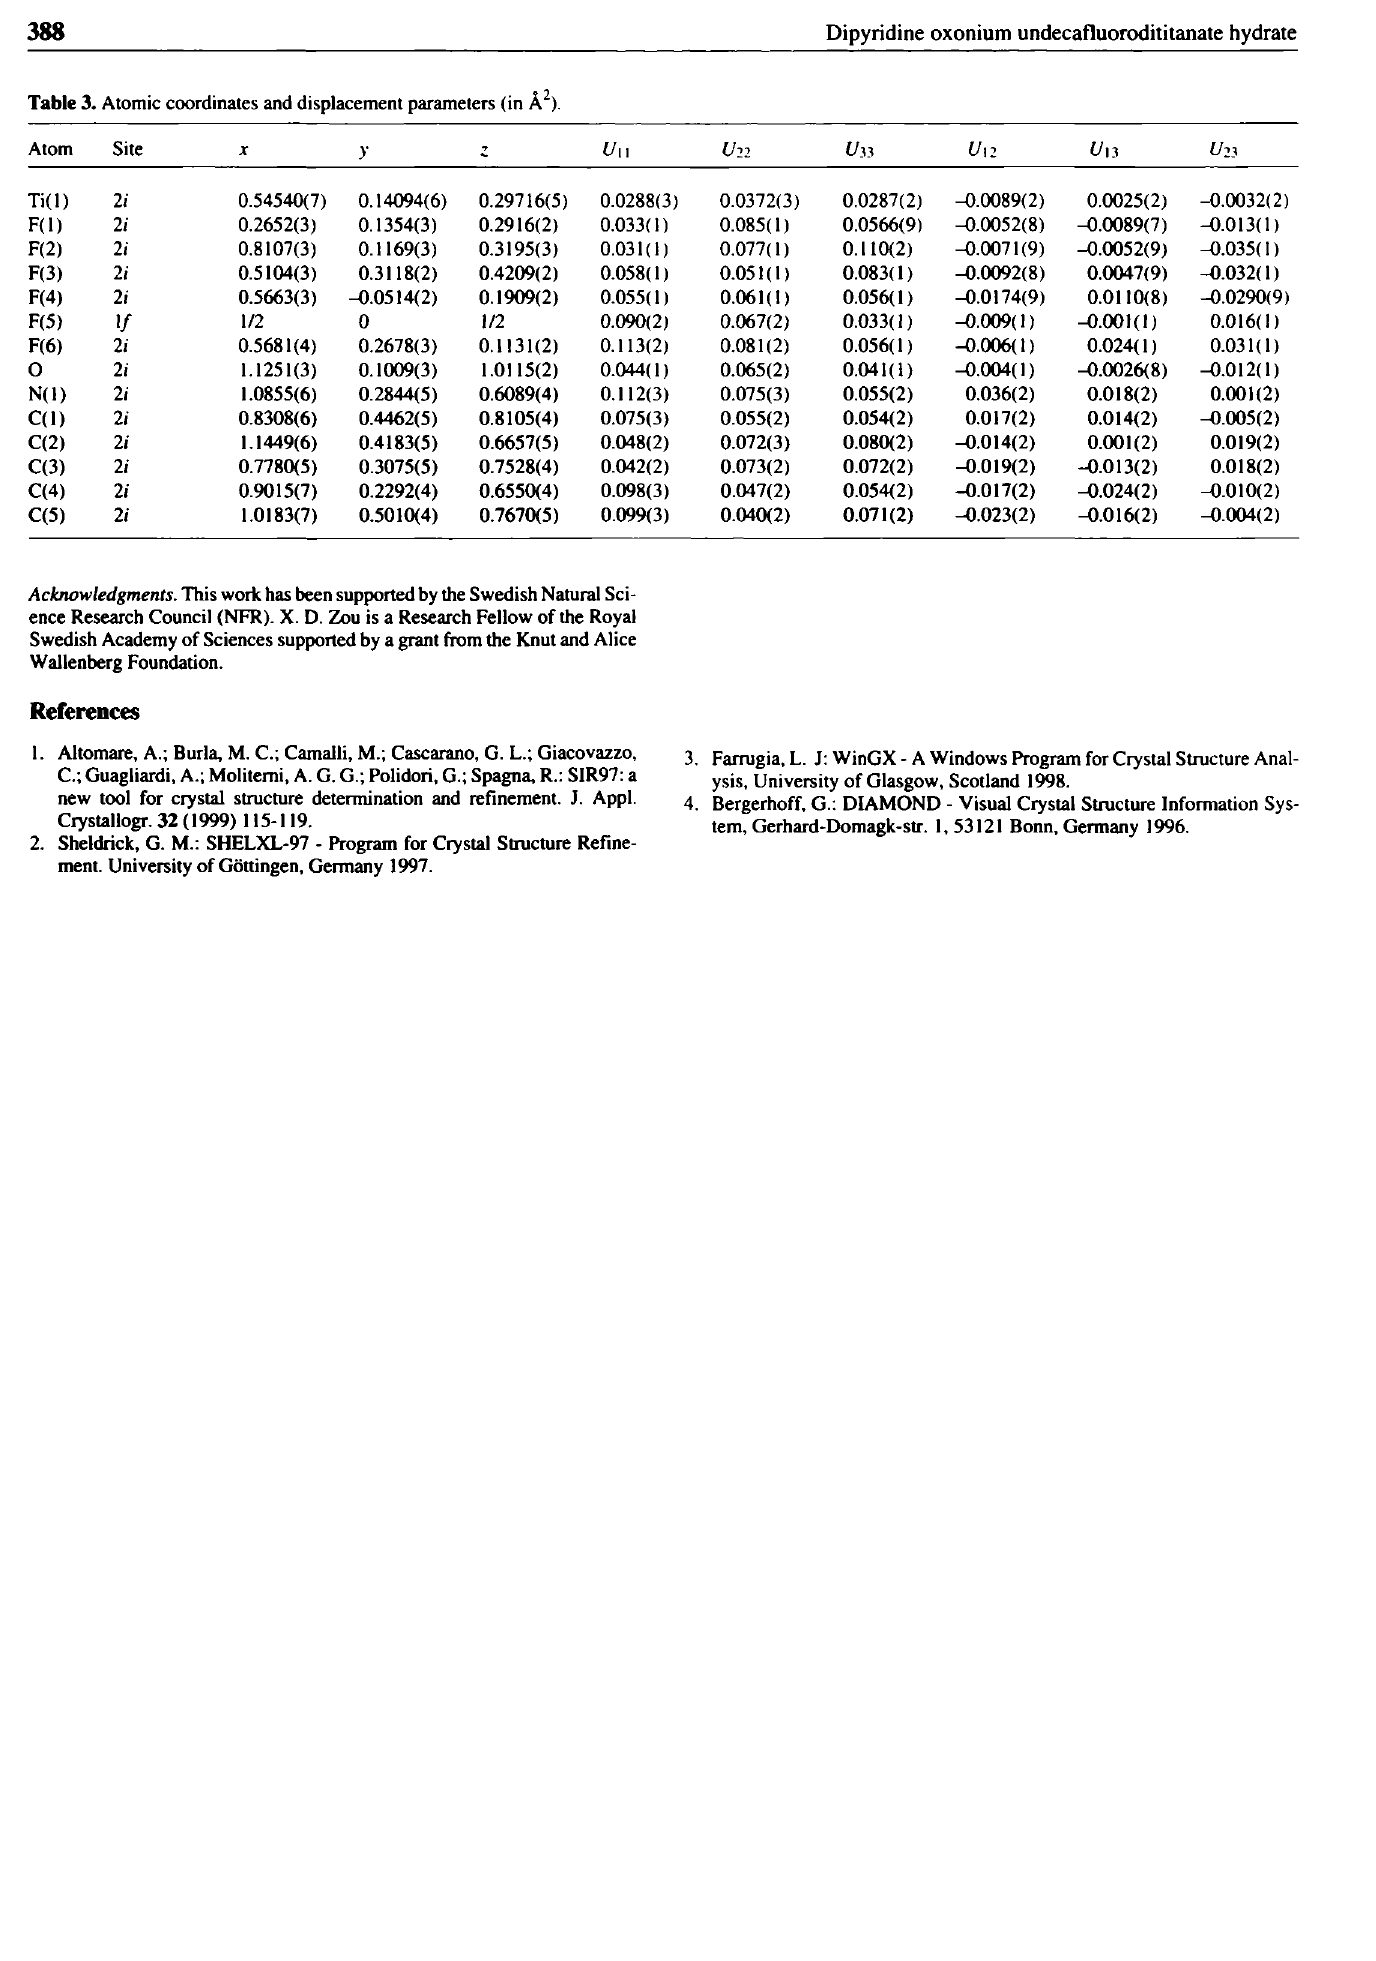
Table 3. Atomic coordinates and displacement parameters (in A 2